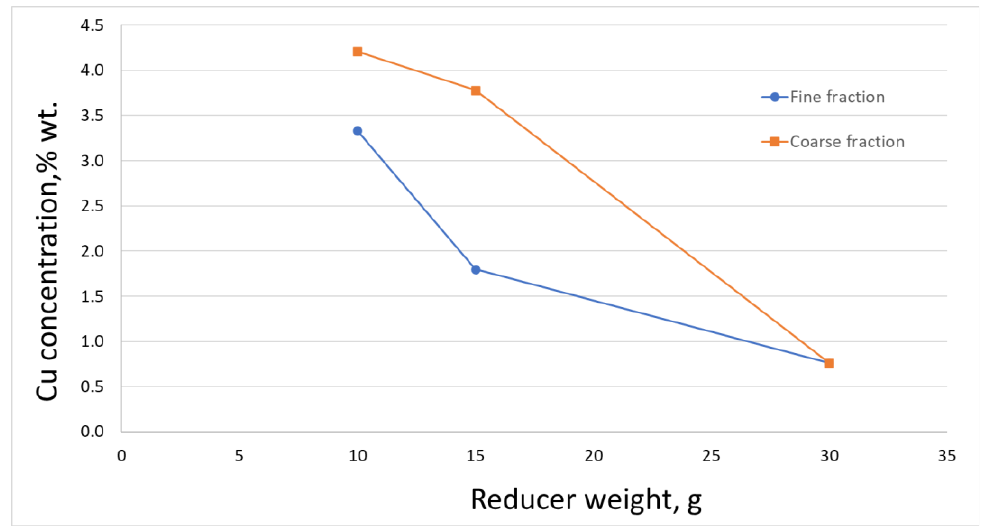
Figure 12. Copper content in the slag after the reduction process with different amounts of the reductant added.